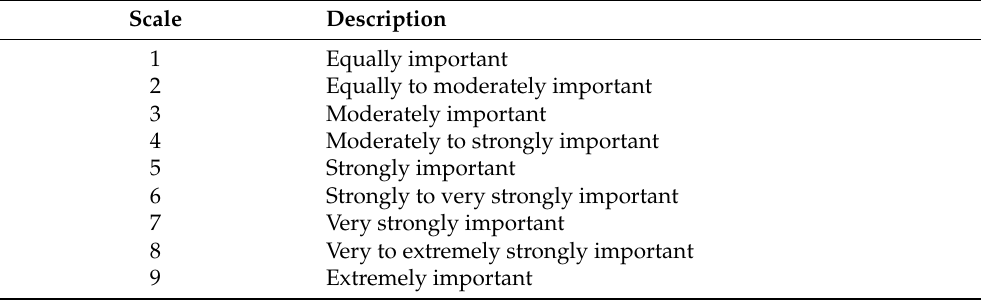
Table 2. Scale for pairwise comparison of the variables.